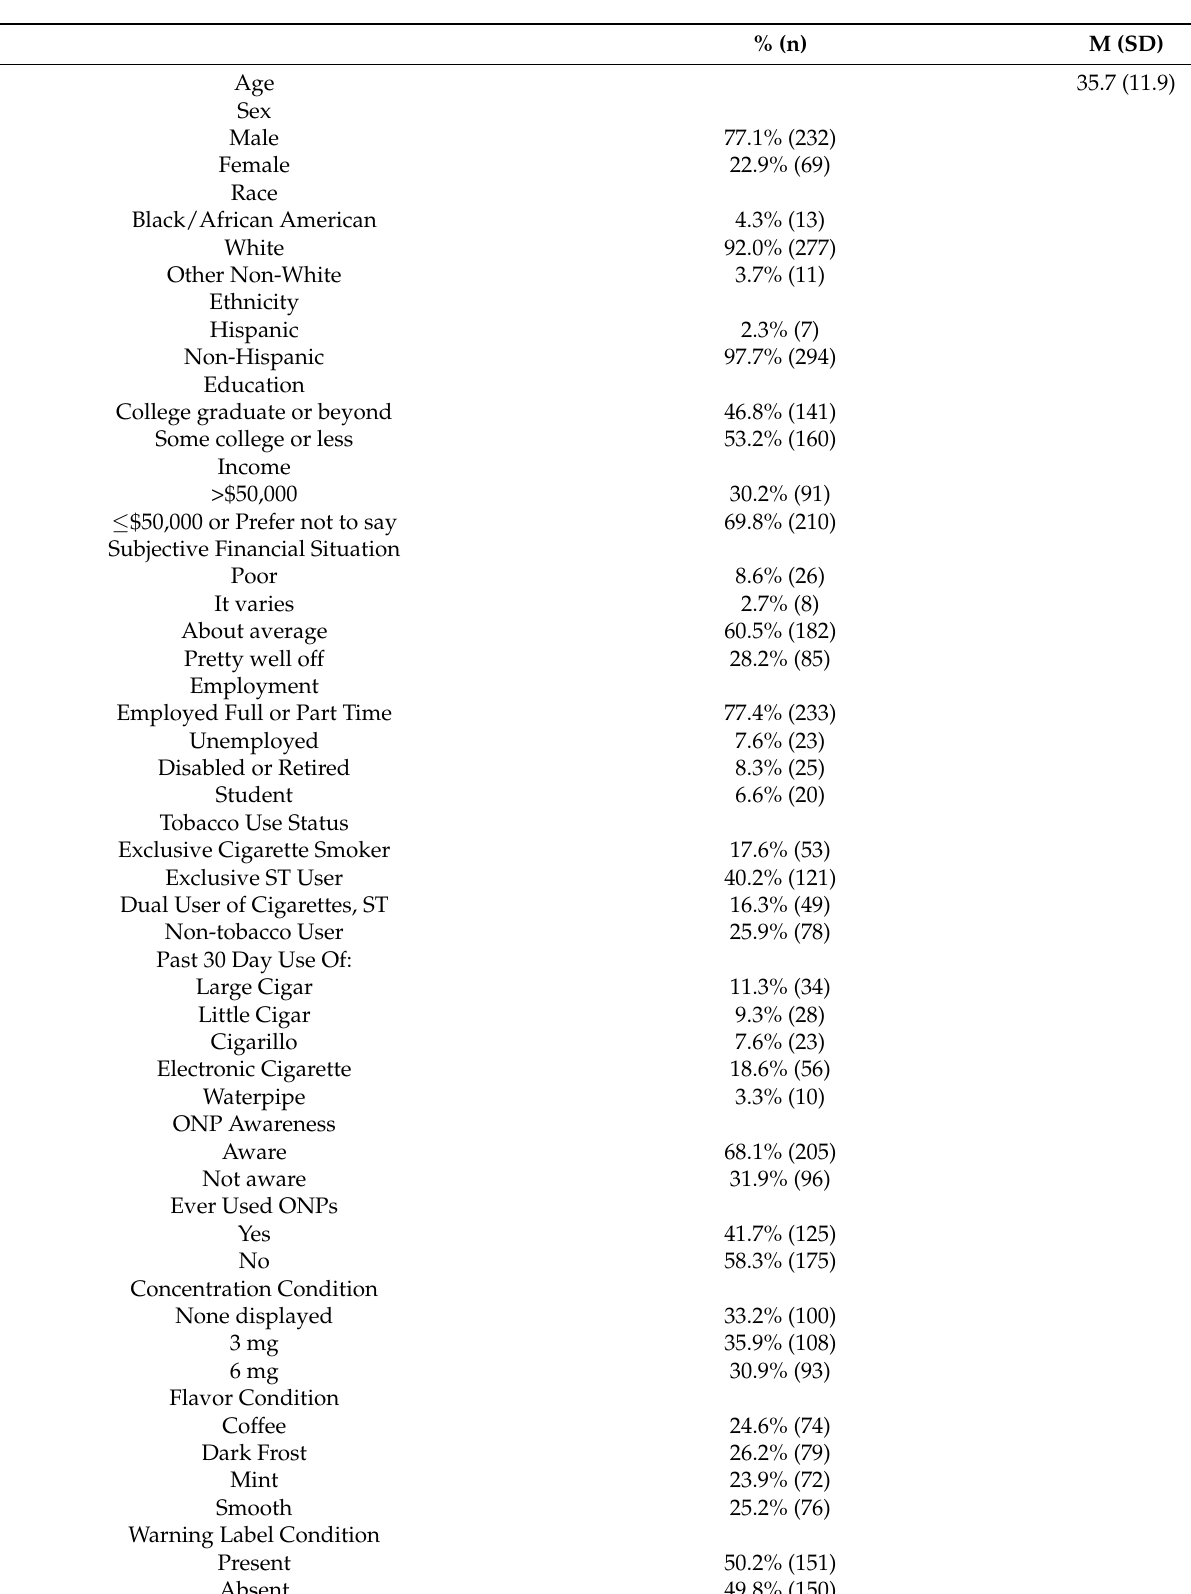
Table 1. Sample characteristics (n =